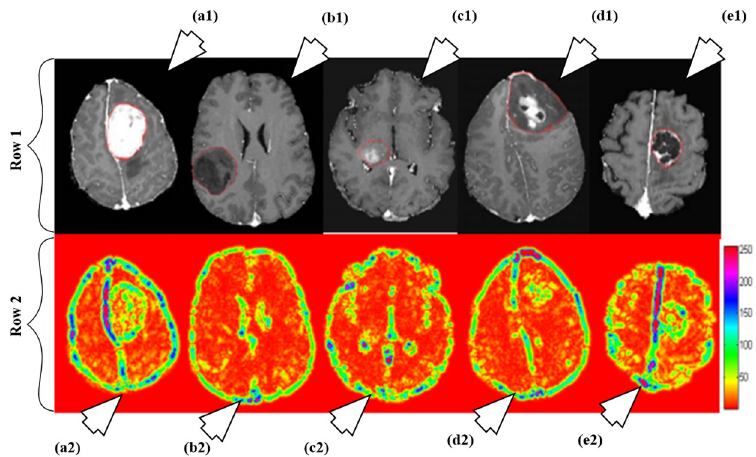
Figure 7. Illustration of different types as per their grades: row 1 and row 2 consists of T1ce brain images and its corresponding texture images, respectively. The images are pointed to by arrow are as